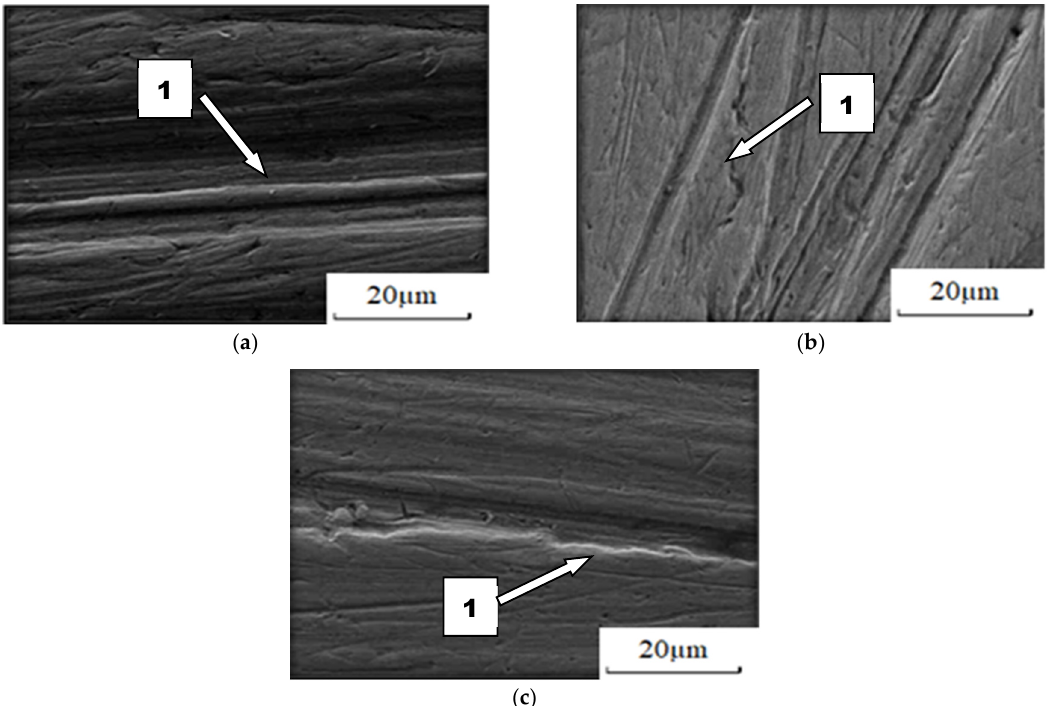
Figure 14. Condition of worn surface of XAR 600 steel in diverse soil conditions: ( a ) light soil, (1) furrowing; ( b ) medium soil, (1) furrowing; ( c ) heavy soil, (1) furrowing.